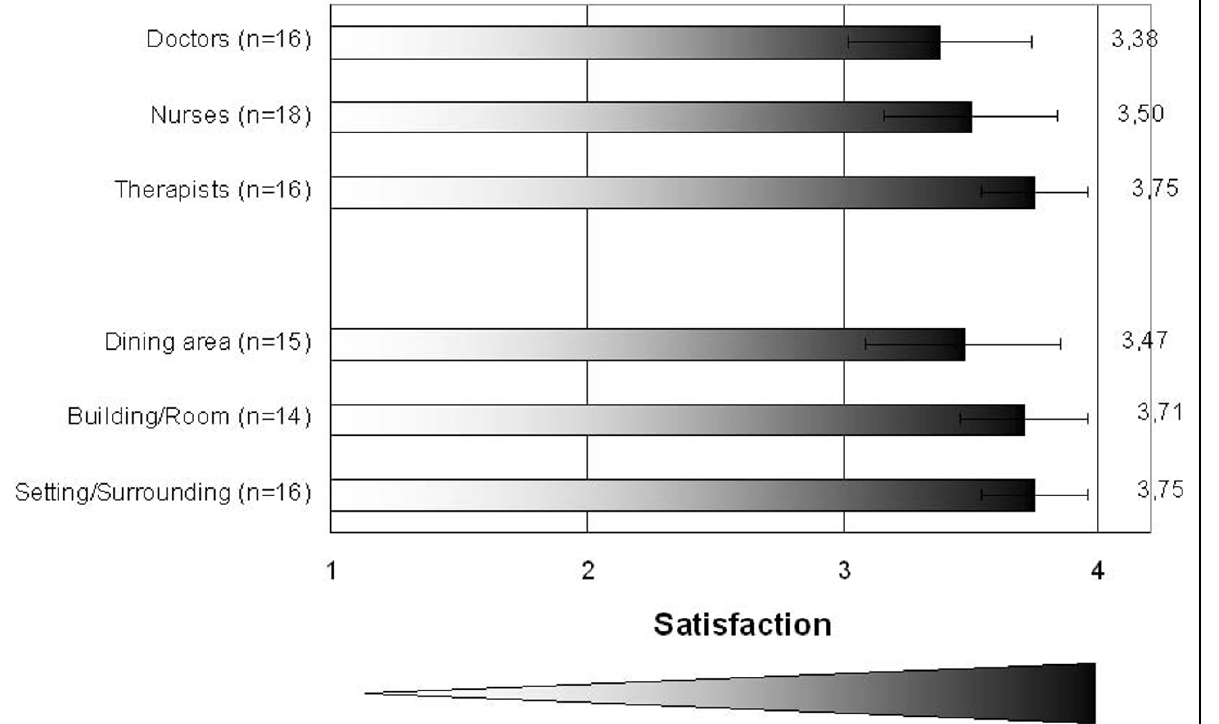
Figure 1 Satisfaction of patient ’ s relatives with structural qualities (Mean and 95% Confidence Interval) from 1 = very unsatisfied to 4 = very satisfied sorted by level of satisfaction